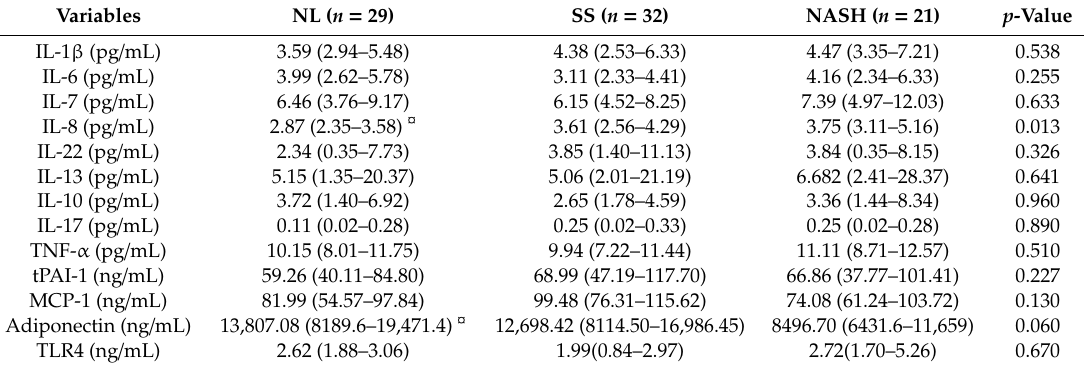
Table 3. Circulating levels of cytokines and TLR4 in the group with morbid obesity according to liver